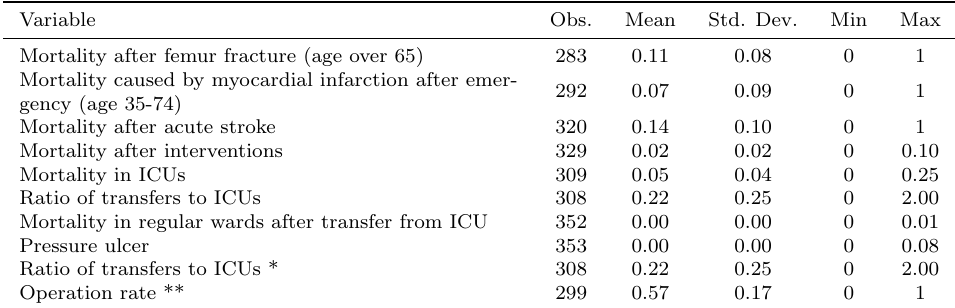
Table 2: Descriptive statistics: mortality by cause of death and other indicators Variable Obs. Mean Std. Dev. Min Max Mortality after femur fracture (age over 65) 283 0.11 0.08 0 1 Mortality caused by myocardial infarction after emer- 292 0.07 gency (age 35-74) Mortality after acute stroke 320